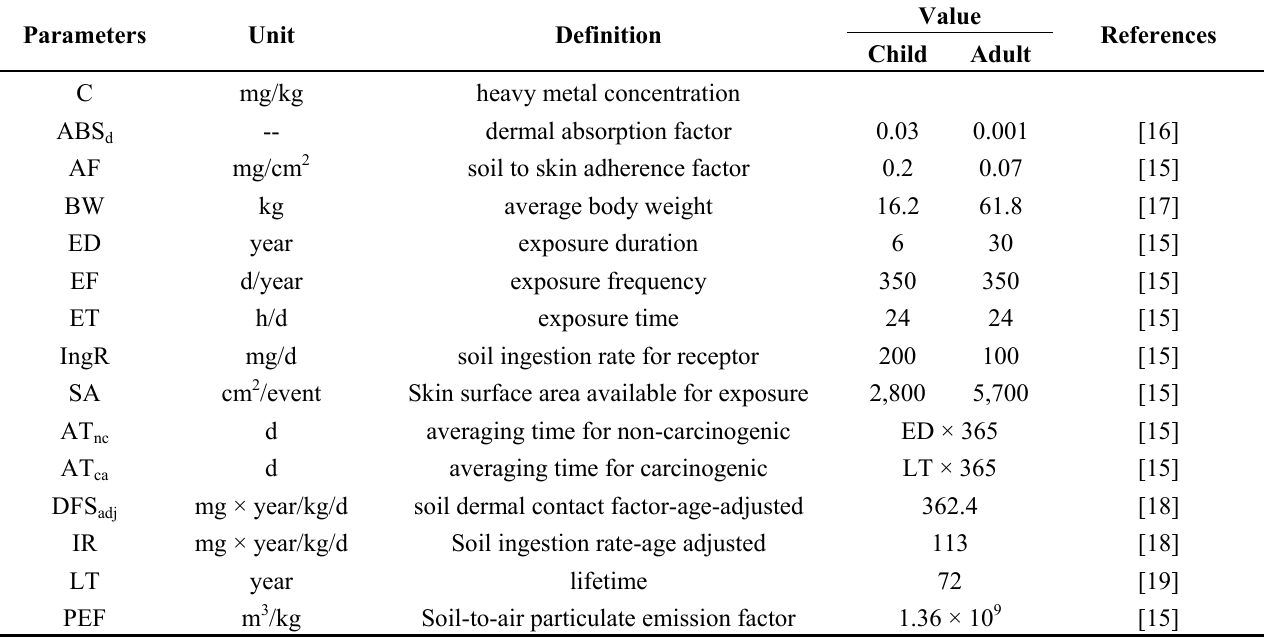
Table 1. Values of variables for human health risk assessment.